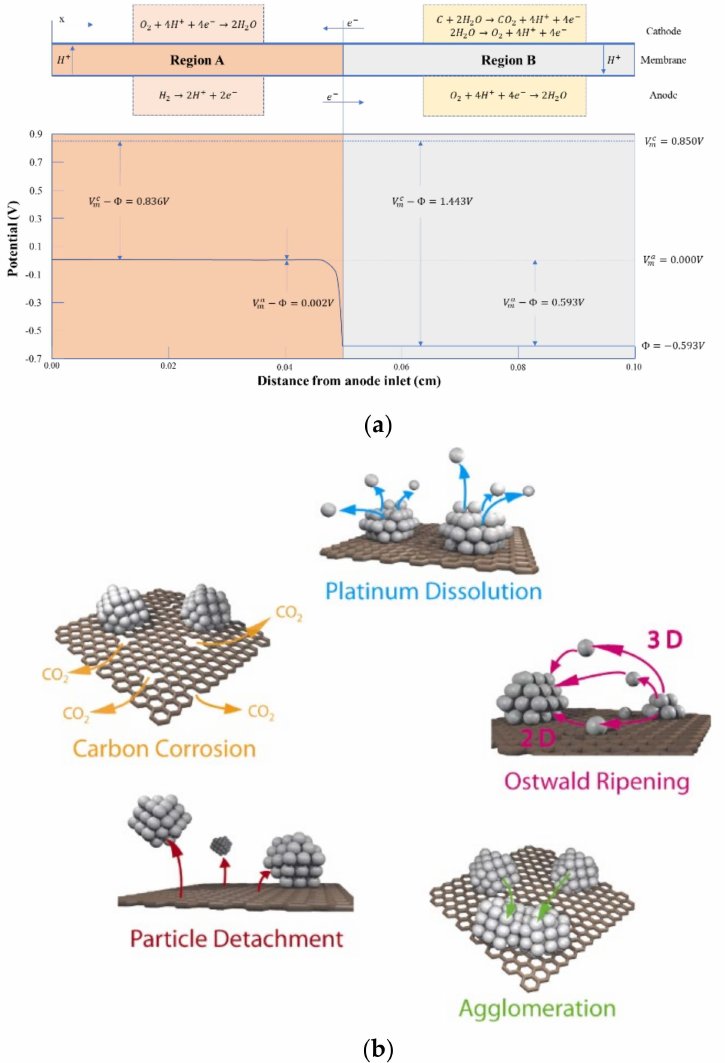
Figure 7. ( a ) Mechanism of reverse current corrosion of carbon support [128]. Copyright 2005 ECS transactions. ( b ) Schematic diagram of degradation mechanism of Pt/C catalyst